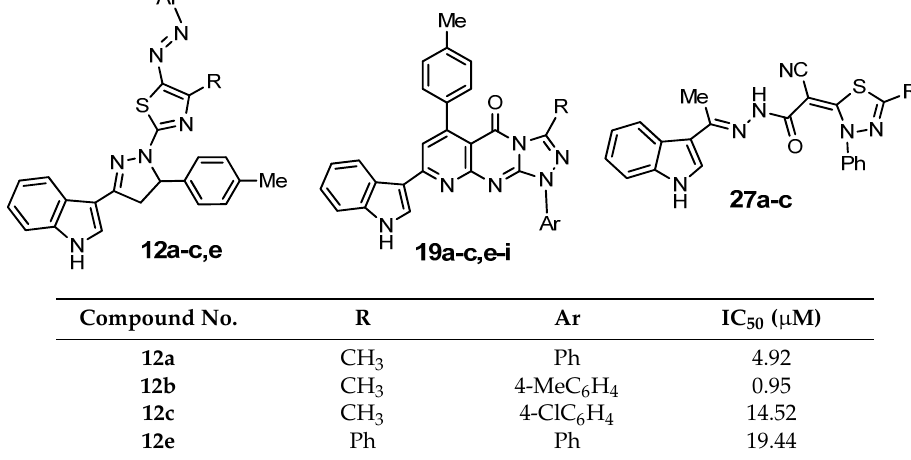
Table 1. The antitumor activities of the tested compounds compared with reference doxorubicin evaluated using MTT assay on the MCF ‐ 7 breast cancer cell line.